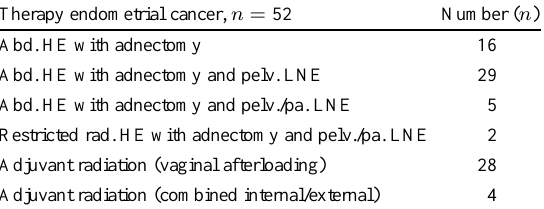
Distribution of therapy modalities in patients with primary endome- trial cancer. Only patients were mentioned, that could be included in prospective analysis ( n = 52). Abd. = abdominal, rad. = radical, HE = hysterectomy, LNE = lymphonodectomy, pelv. =